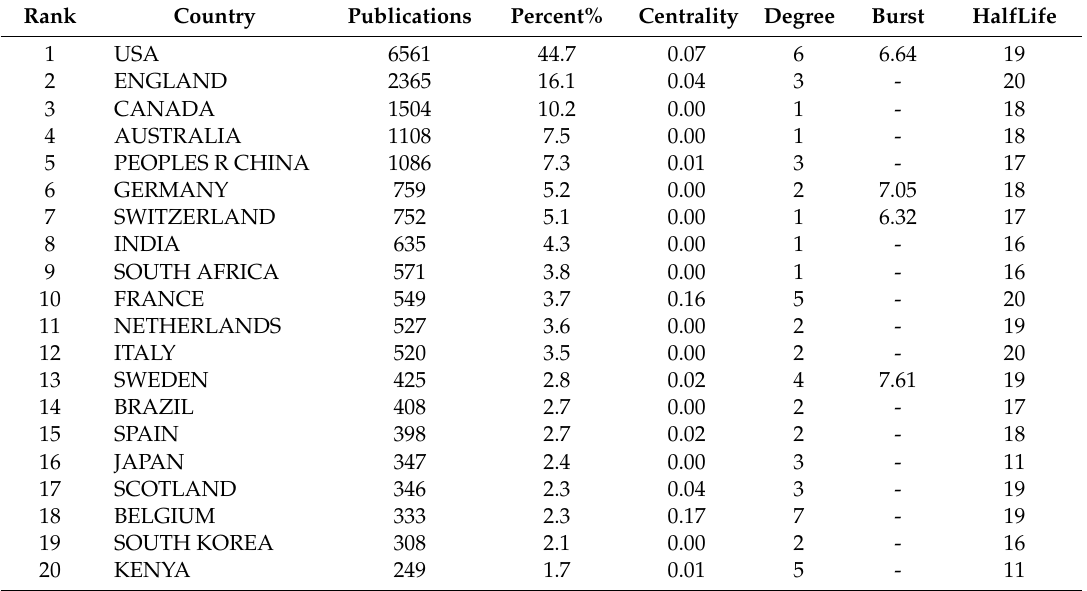
Table 4. The top 20